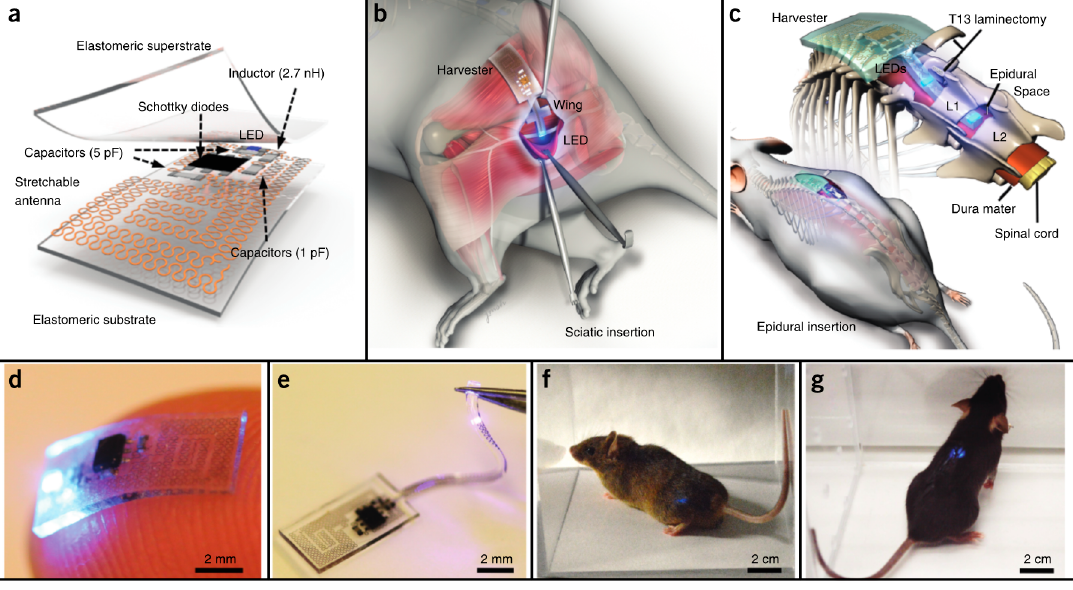
Figure 4. ( a ) Schematic of the optoelectronic system and ( b , c ) implantation site. ( d , e ) Photographs of the functioning device; and ( f , g ) mouse implantation with the LED operating. Reproduced with permission from